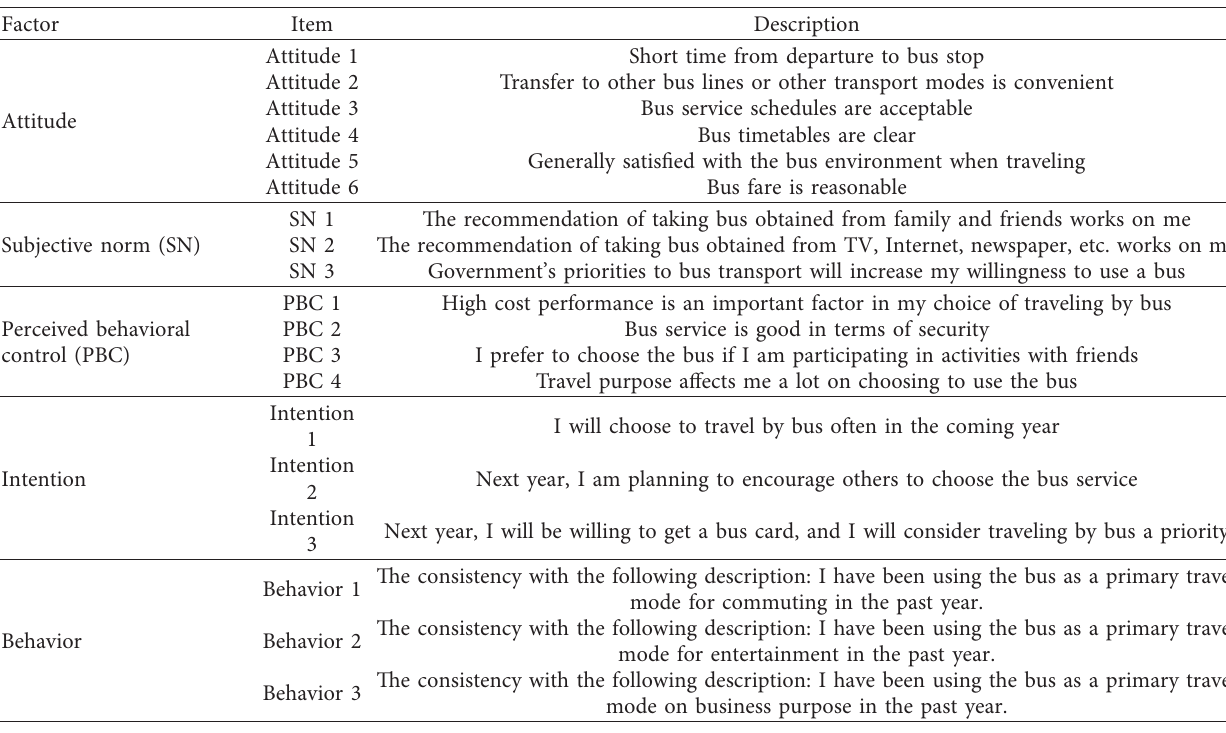
Table 1: Likert-type rating scale for